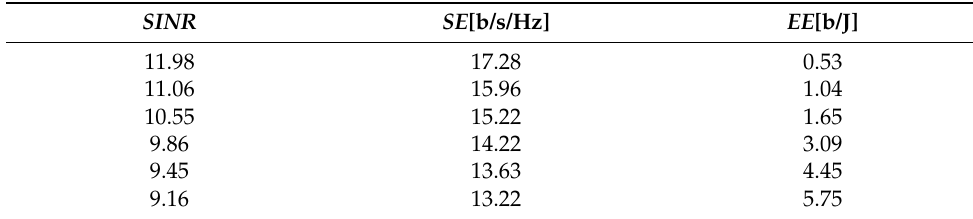
Table 3. Simulation results (after averaging).